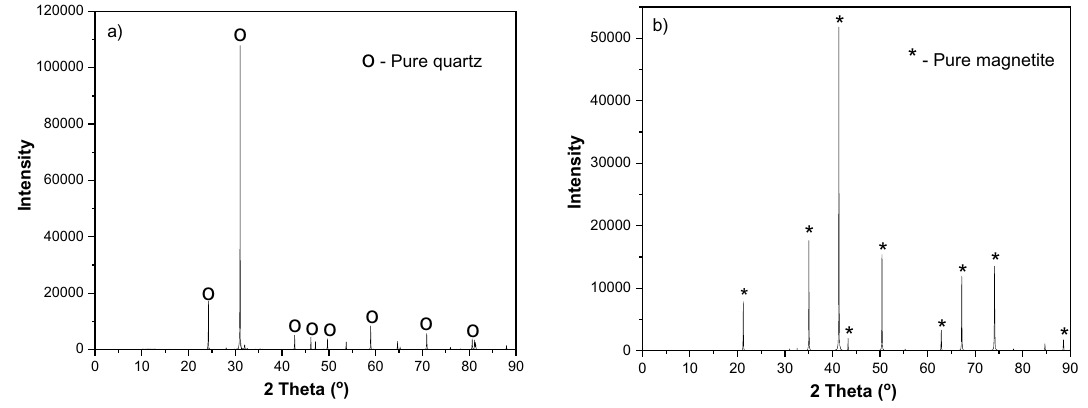
Figure 2. XRD pattern for the examined samples ( a ) pure quartz; ( b ) pure